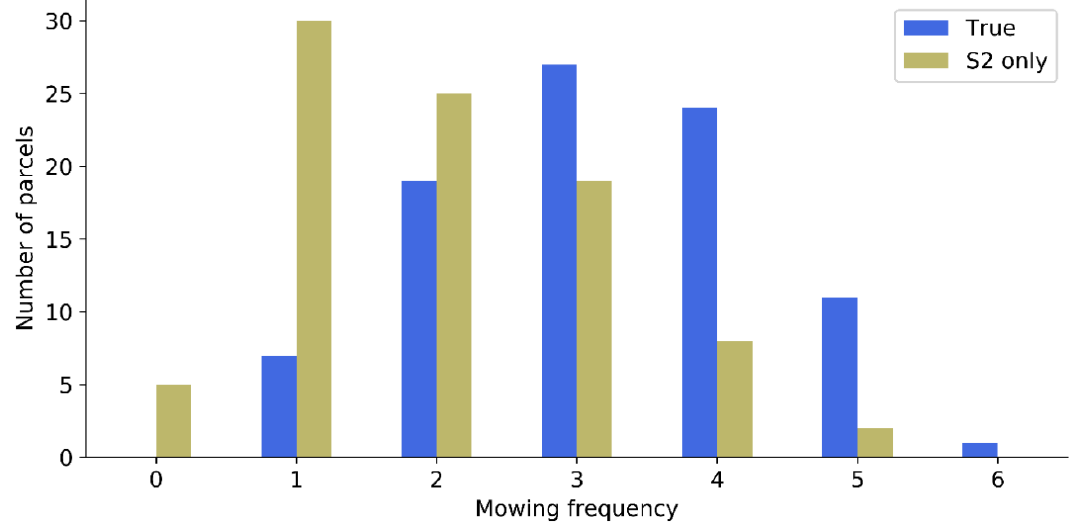
Figure 9. Number of mowing events per year from the validation dataset and detected for grassland parcels with continuous management information.